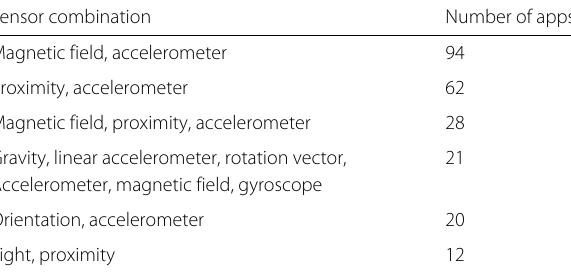
Table 6 Number of apps using different combinations of